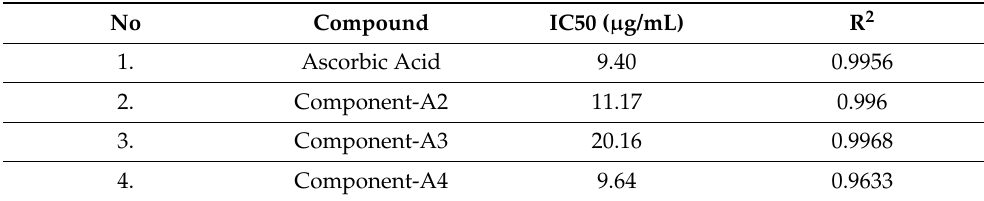
Table 4. UV spectrophotometer observations of the scavenging effect of AA and isolated components A-2, A-3, and A-4 using the DPPH method (average of three tests).